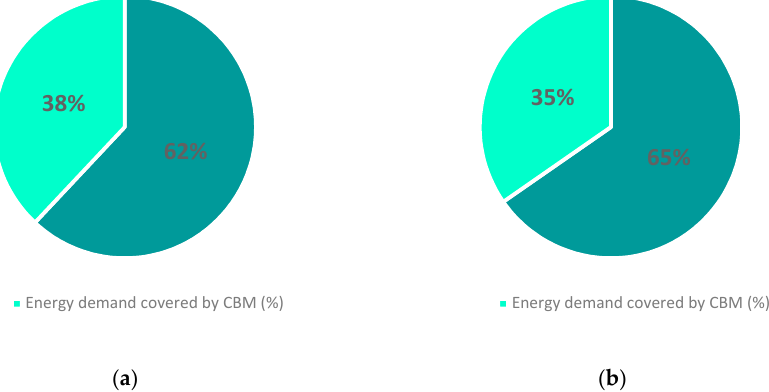
Figure 5. Percentage of energy demand covered by the use of CBM. ( a ) Russia, ( b ) Europe.